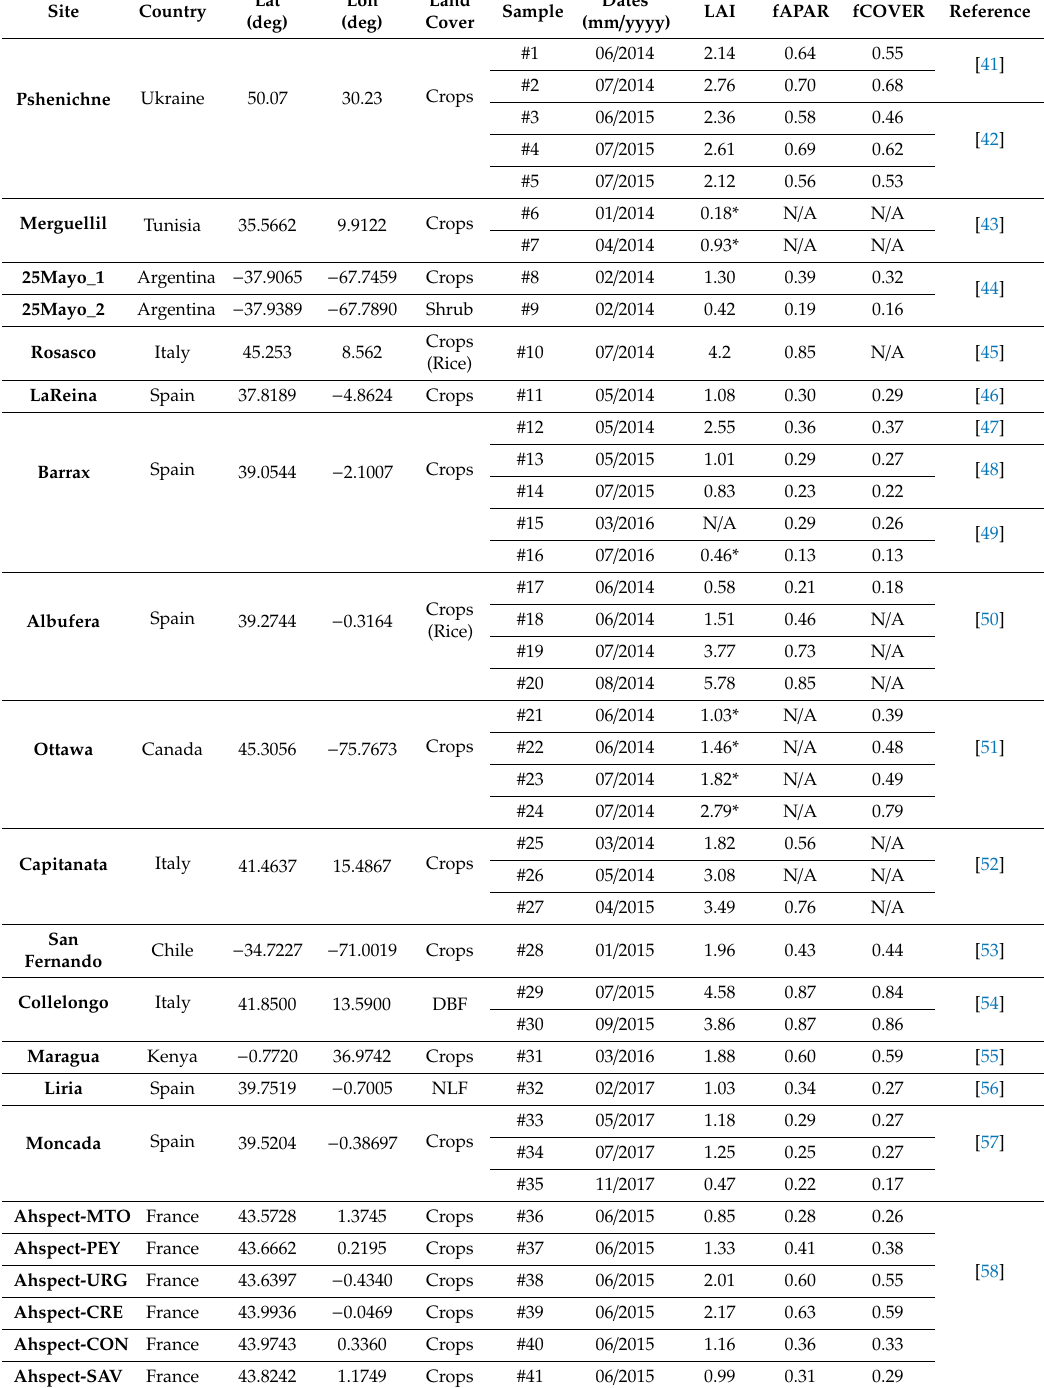
Table 2. Characteristics of the validation sites and associated ground biophysical values over an area of 3 km × 3